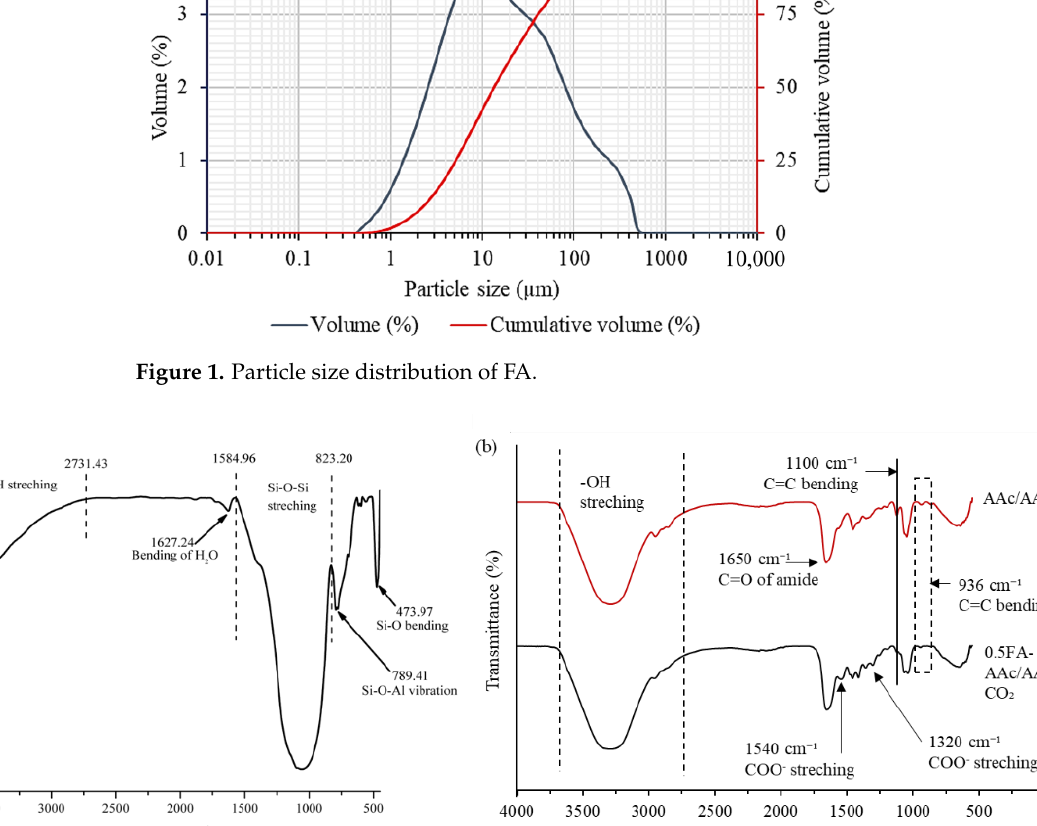
Figure 2. The FTIR spectra ( a ) FA and ( b ) the AAc/AAm hydrogel and 0.5FA-AAc/AAm+CO 2 (hy- drogel after CO 2 capture).